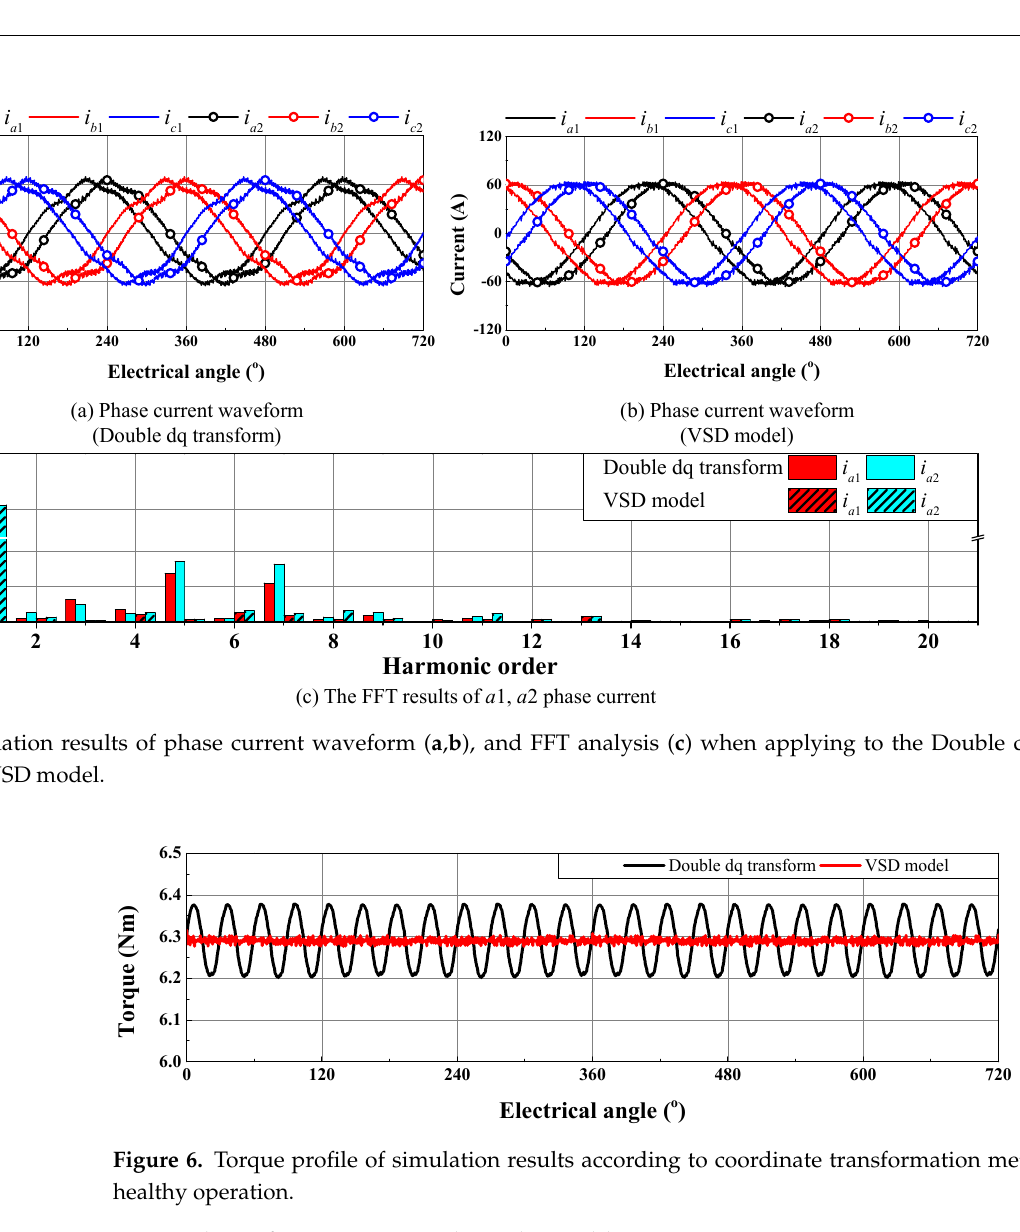
Figure 4. Simulation results of rotational coordinate command, feedback currents ( a , d ) and stational coordinate current trajec- tory ( b , c , e , f ) when applying to the Double dq transform and VSD model.